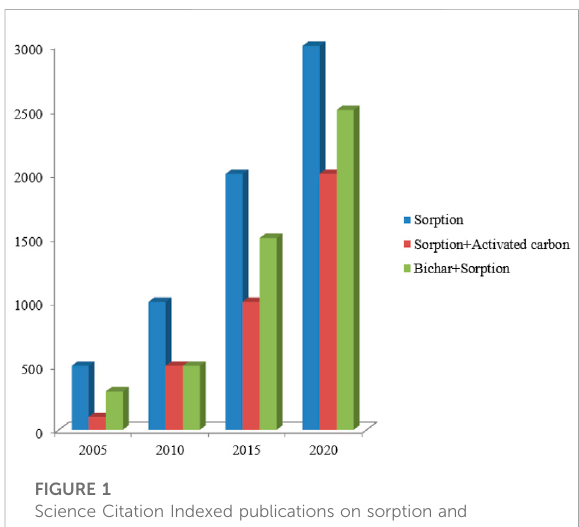
FIGURE 1 Science Citation Indexed publications on sorption and sorption related to biochar and activated carbon (2005 –